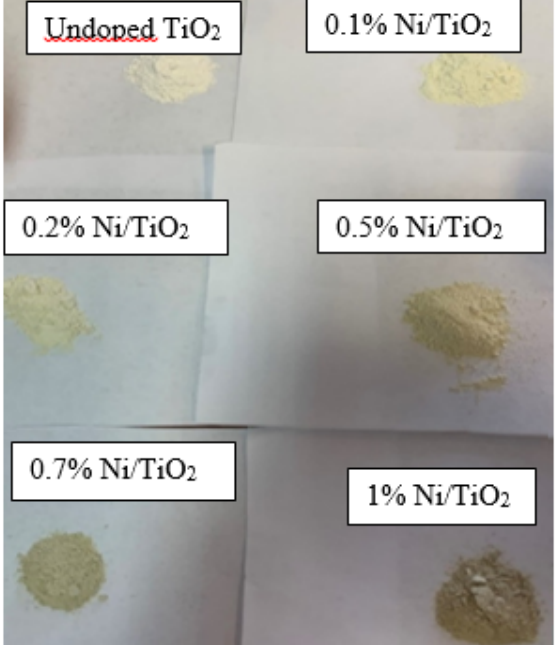
Fig. 5. The color of Ni-TiO